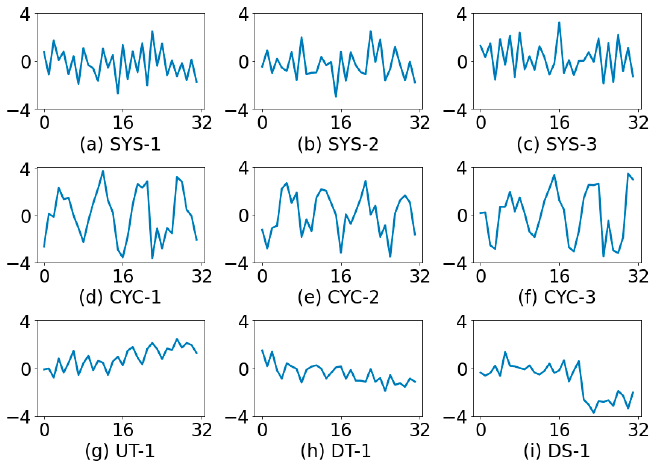
Figure 13. Examples of misclassification by traditional classifiers. ( a – c ) SYS was misclassified as NOR. ( d – f ) CYC was misclassified as NOR. ( g ) UT was misclassified as US. ( h ) DT was misclassified as DS. ( i ) DS was misclassified as DT.